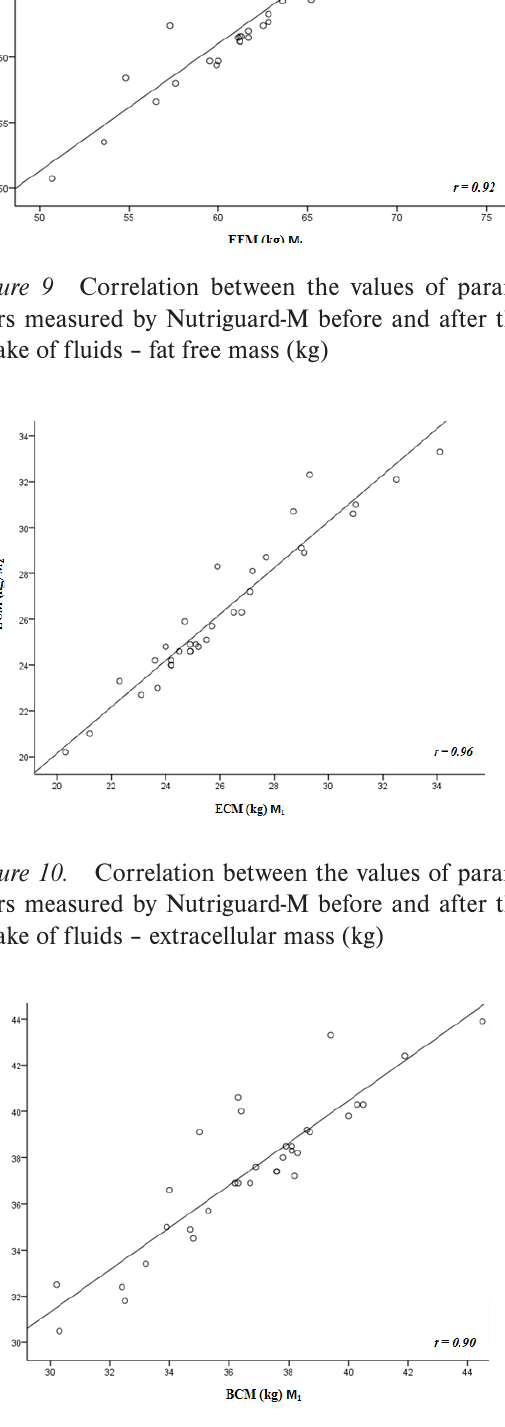
Figure 8. Correlation between the values of param- eters measured by Nutriguard-M before and after the intake of fluids – total body water (kg)